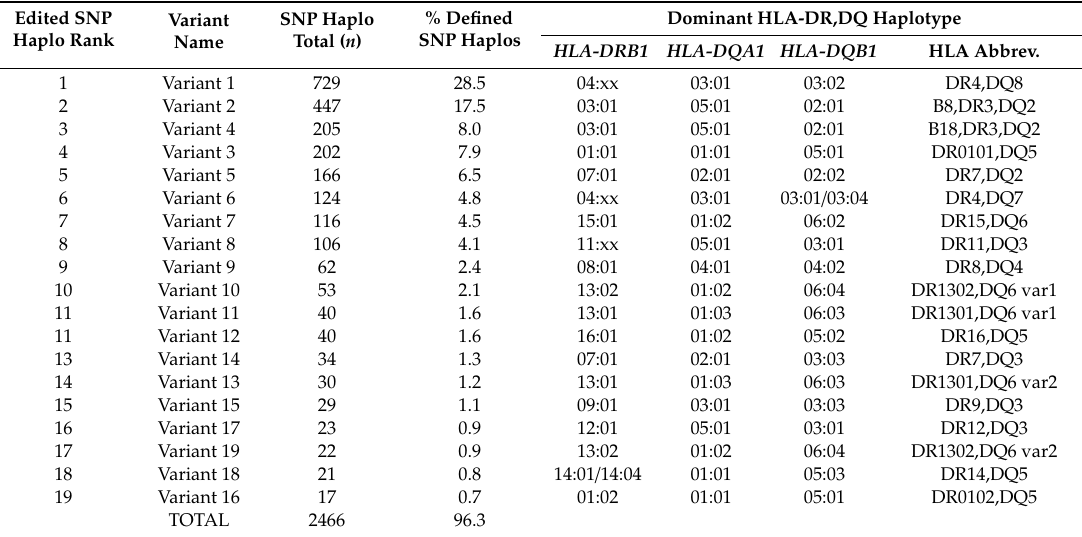
Table 3. Major edited 27-SNP haplotypes shared by both T1DGC studies.